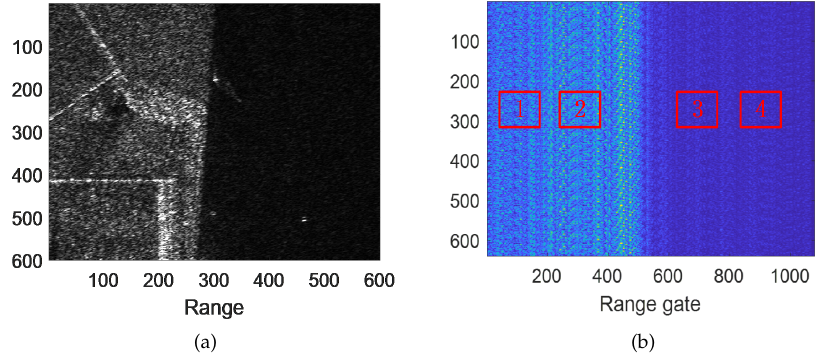
Figure 3. Background: ( a ) the background image, ( b ) the echo of background.